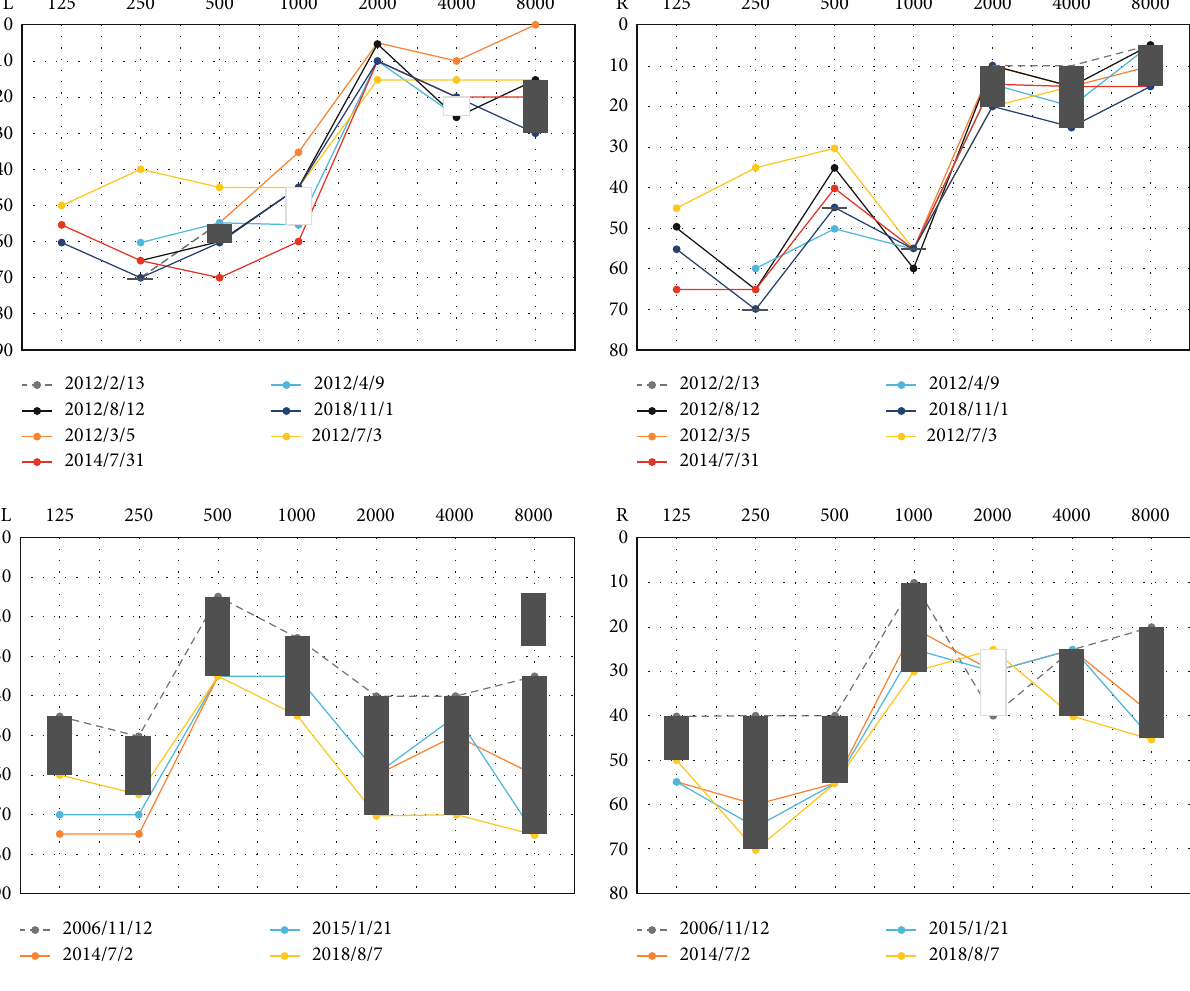
Figure 4: Typical cases with stable and progressive pure tone hearing